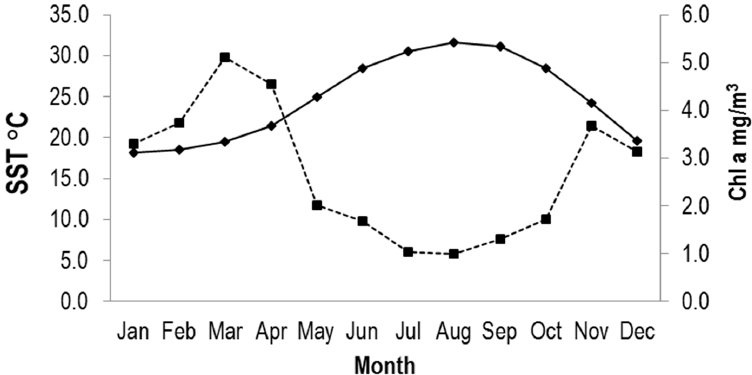
Figure 7. Variability of chlorophyll a (dotted line) and sea surface temperature (continuous line) in the central and southern coastal region of Sonora and adjacent deep zone in the Gulf of California. An inverse lineal relationship (R 2 = 0.73) was observed between temperature and Chl-a concentration (Figure 8).